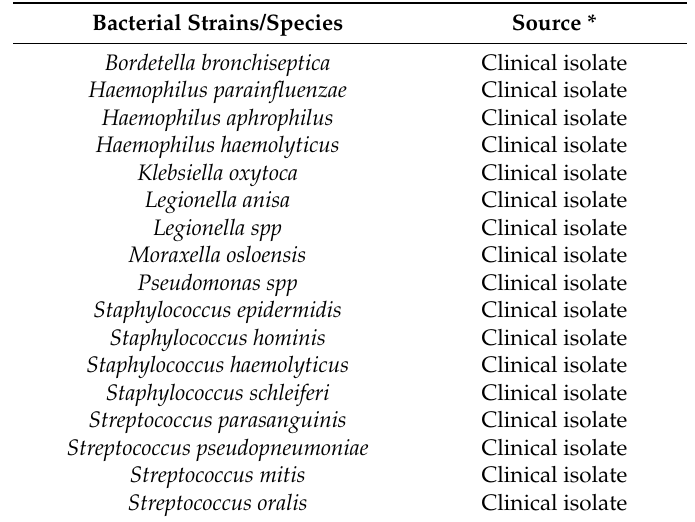
Table 2. Source of exclusion bacterial strains used to assess the oligo probes